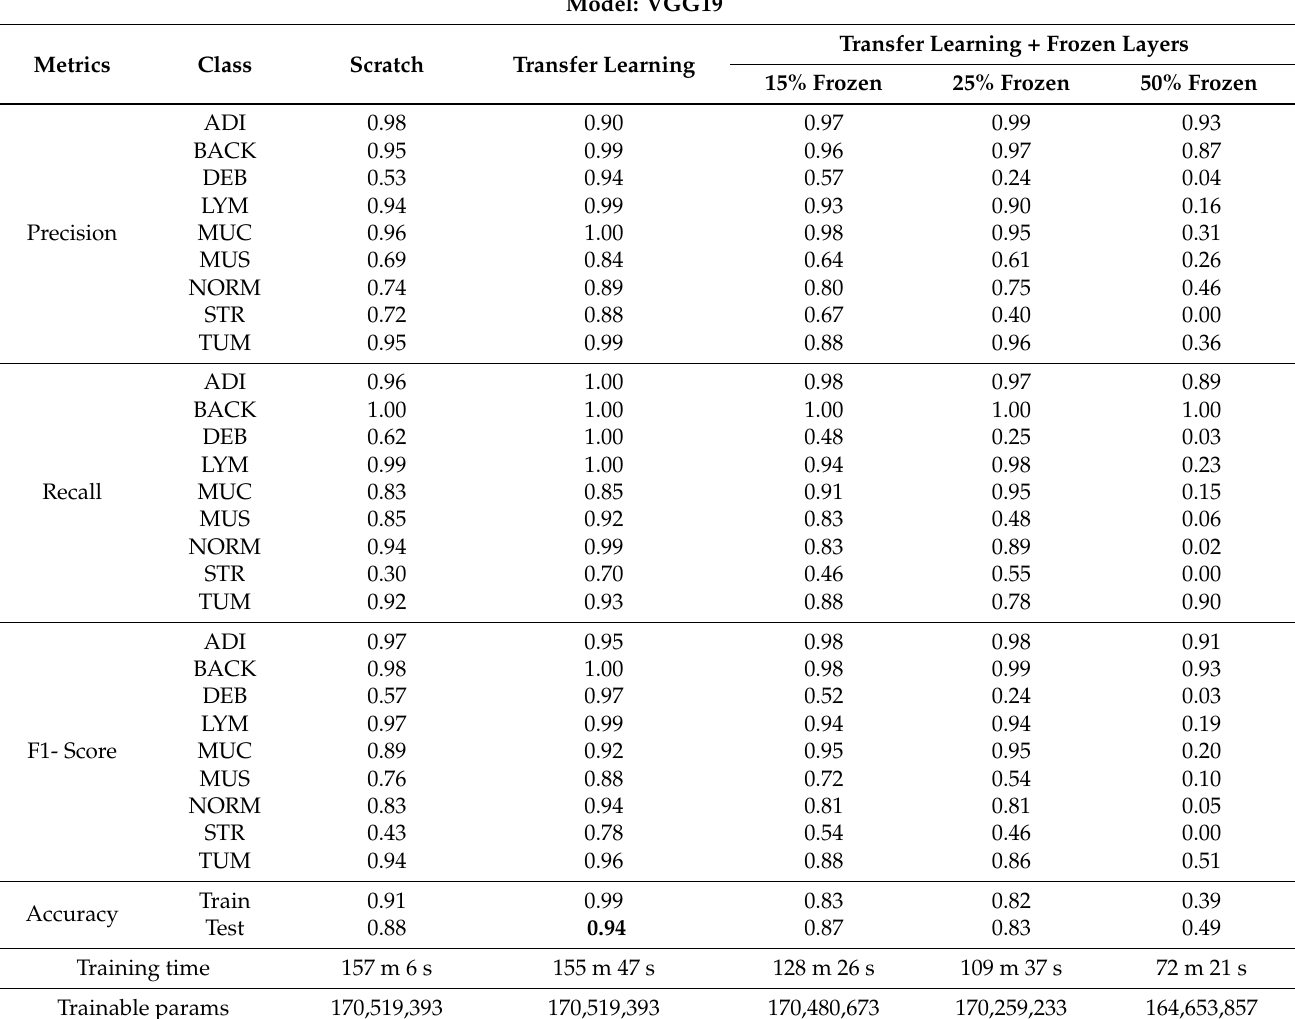
Table 2. Results obtained in the training and validation process from scratch, with transfer learning and frozen different percentages of the model layers. Model: